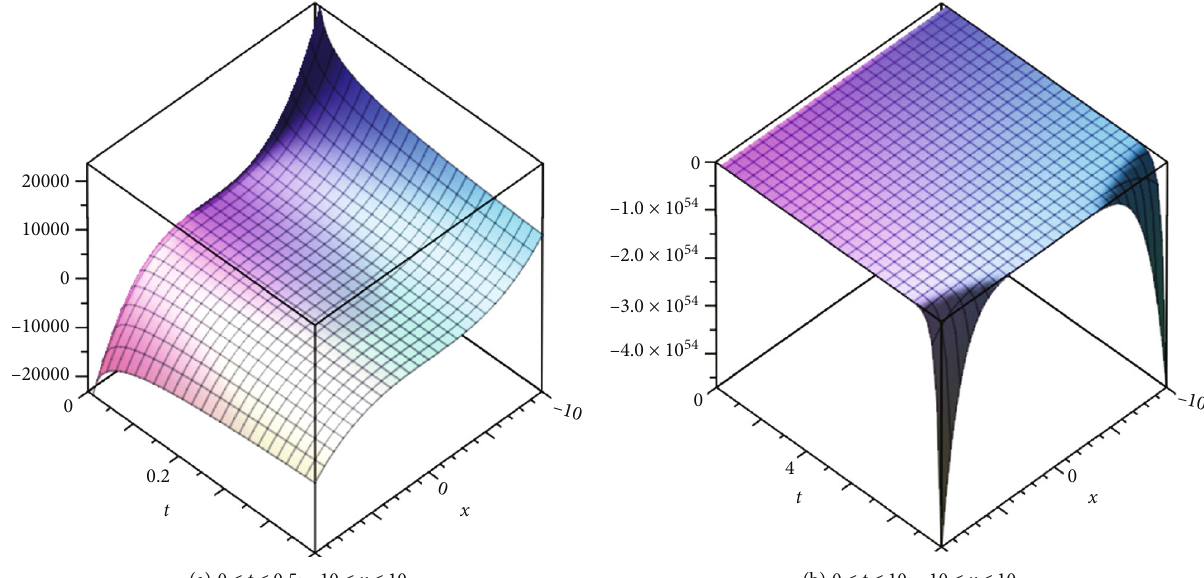
ð x , t Þ of Equation (1) for a 3